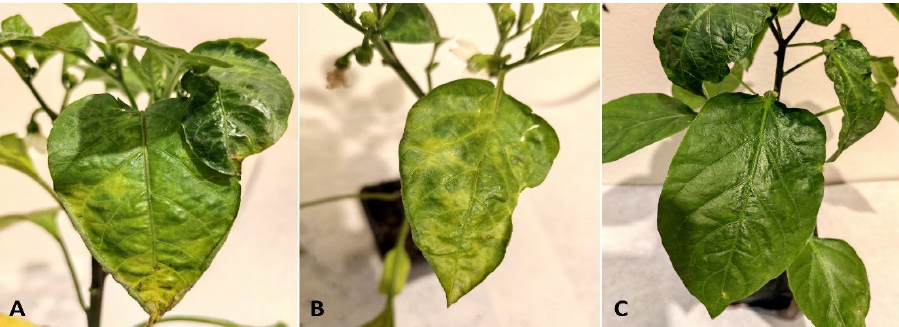
Figure 1. Symptoms development after 14 days post inoculation with ToBRFV on ( A ) positive control plants (non-treated with AMF or Azospirillum), ( B ) ToBRFV-infected plants treated with AMF and Azospirillum and ( C ) negative control plants (ToBRFV negative) treated with AMF and